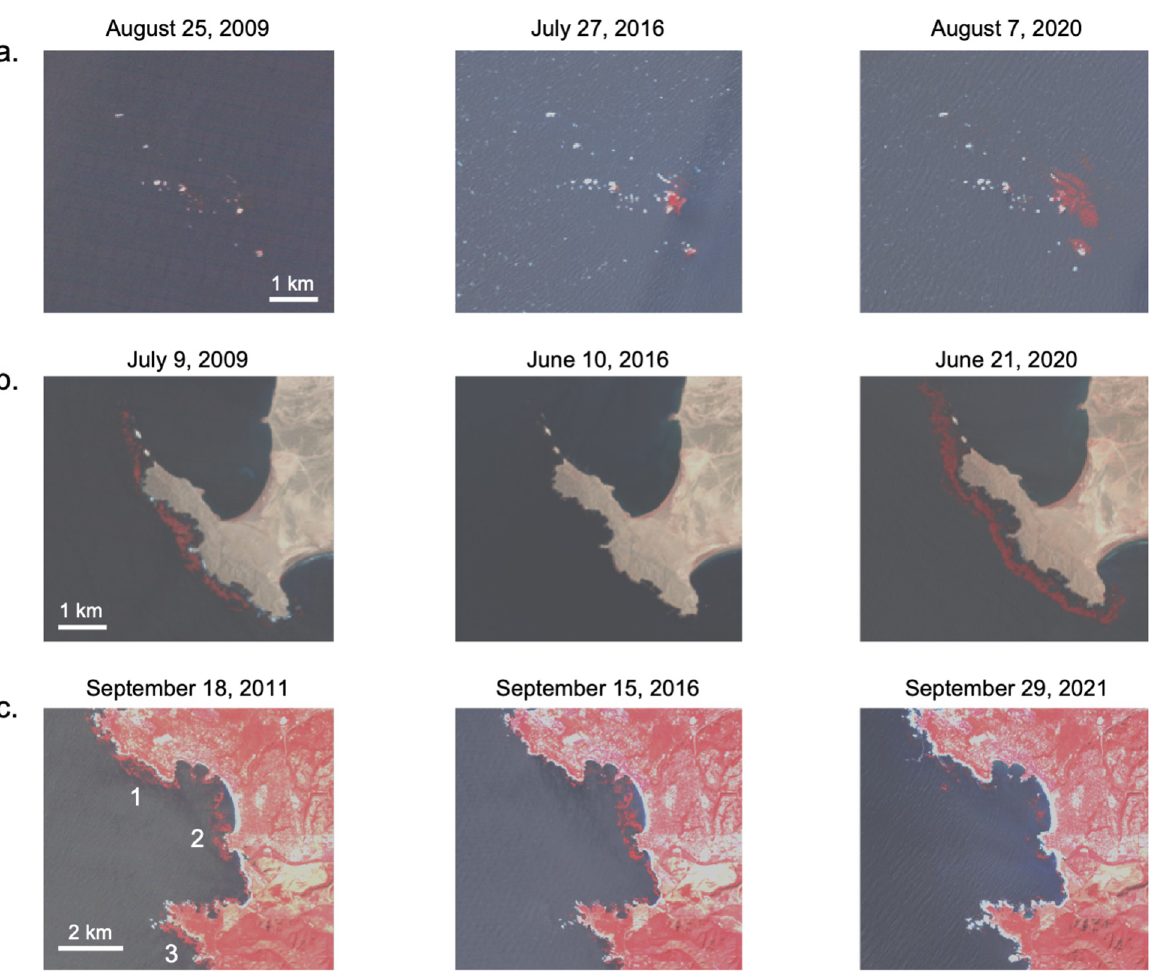
Fig 5. False color Landsat images showing change in kelp canopy. a.) Rogue Reef, Oregon, b.) Bahı´a Tortugas, Baja California Sur, and c.) Monterey Peninsula and Carmel Bay, California before, during, and after the marine heatwave events. Locations shown in Fig 3. Kelp canopy has high reflectance in the near infrared which has been colored red in these images for visualization purposes. The numbers in bottom left image represent 1. Pescadero Point, 2. Carmel Point, and 3. Point Lobos. Landsat imagery from USGS.